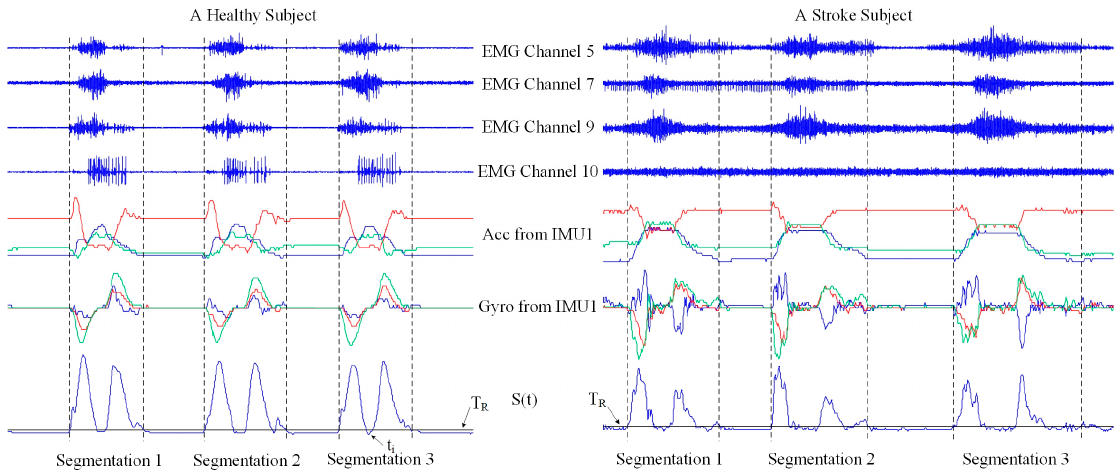
Figure 4. Illustration of the data segmentation process when representative data channels are used as examples from a healthy subject and a stroke subject performing TASK 8, respectively. For each subject, there are three repetitions of task performance. The black solid line represents the threshold T R .